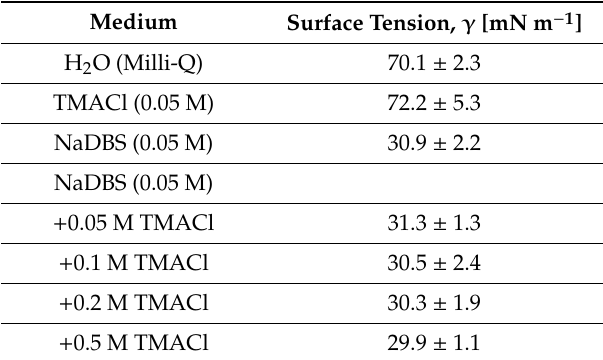
Table 1. Surface tension of aqueous